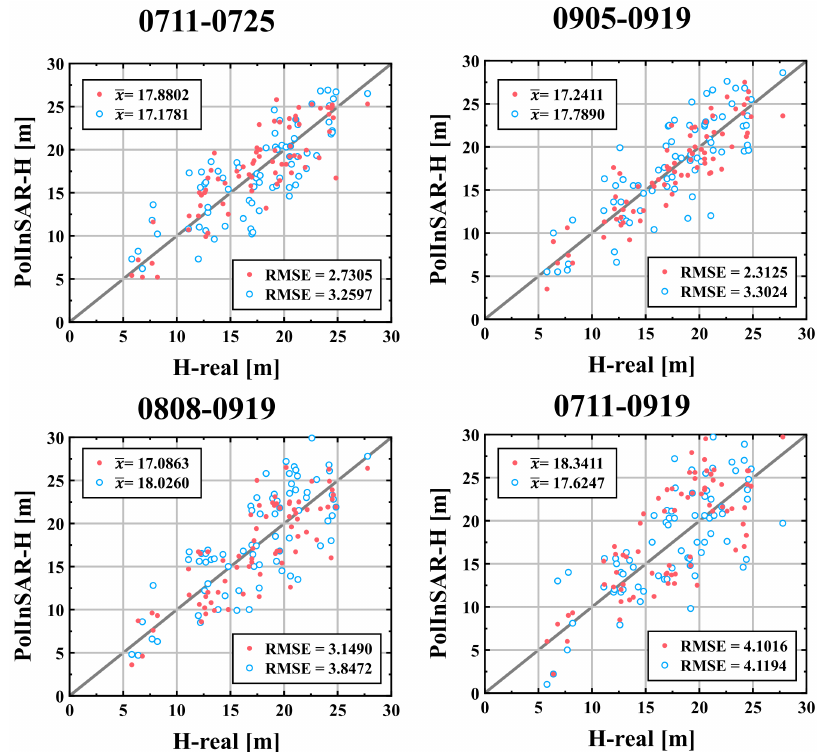
Figure 15. Scatter plots of the height inversions based on the improved model and the validation data. The red points are the inversion heights of the improved models proposed in this study. The blue points are the nonlinear least squares model inversion heights. RMSE and x are the root mean square error and the mean value of the inversion results,